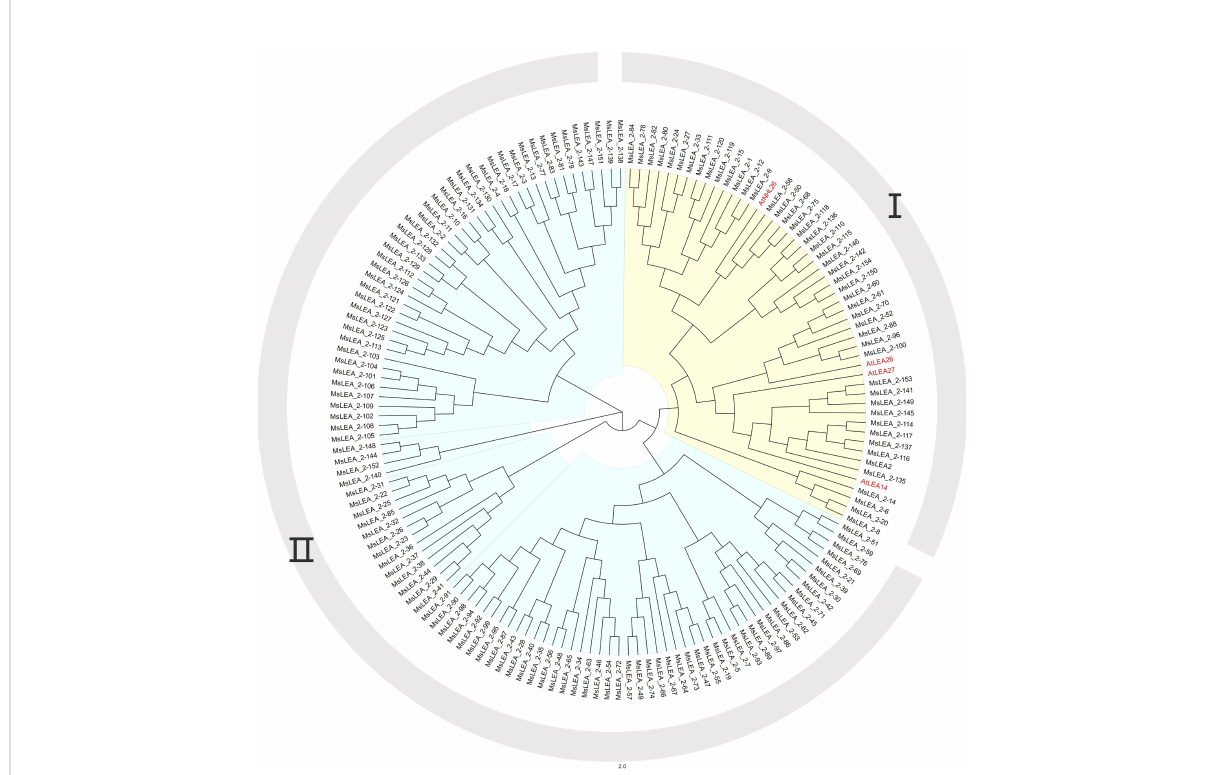
FIGURE 1 Phylogenetic analysis of LEA_2 protein family from Medicago sativa and Arabidopsis thaliana . The phylogenetic tree was generated using Clustal X tool, and the MEGA version 10.6.2 software with default parameters implementing the maximum likelihood (ML) method, the bootstrap test value was set to 1000. The black colored genes are Medicago sativa LEA_2 Family Genes. The red colored genes are Arabidopsis thaliana LEA_2 Family Genes. The whole MsLEA_2 family can be divided into two groups: group I and group